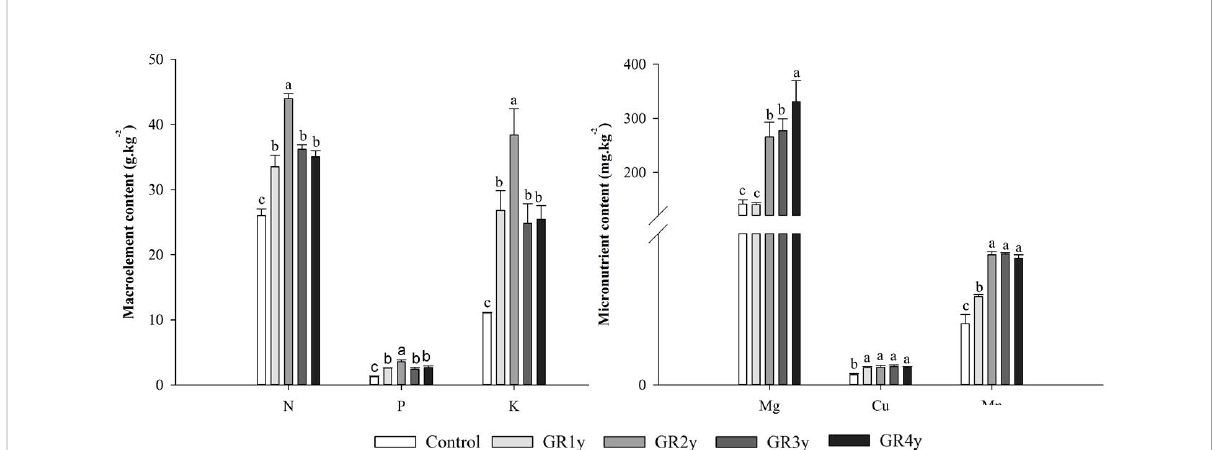
FIGURE 7 Effect of grazing rest during the spring regreening period on the mineral element content of the degraded alpine meadow vegetation. Bars represent SEs. Common letters above columns indicate no signi fi cant difference at P = .05. GR 1y, GR 2y, GR 3y, and GR 4y mean grazing rest for 1, 2, 3, and 4 years,